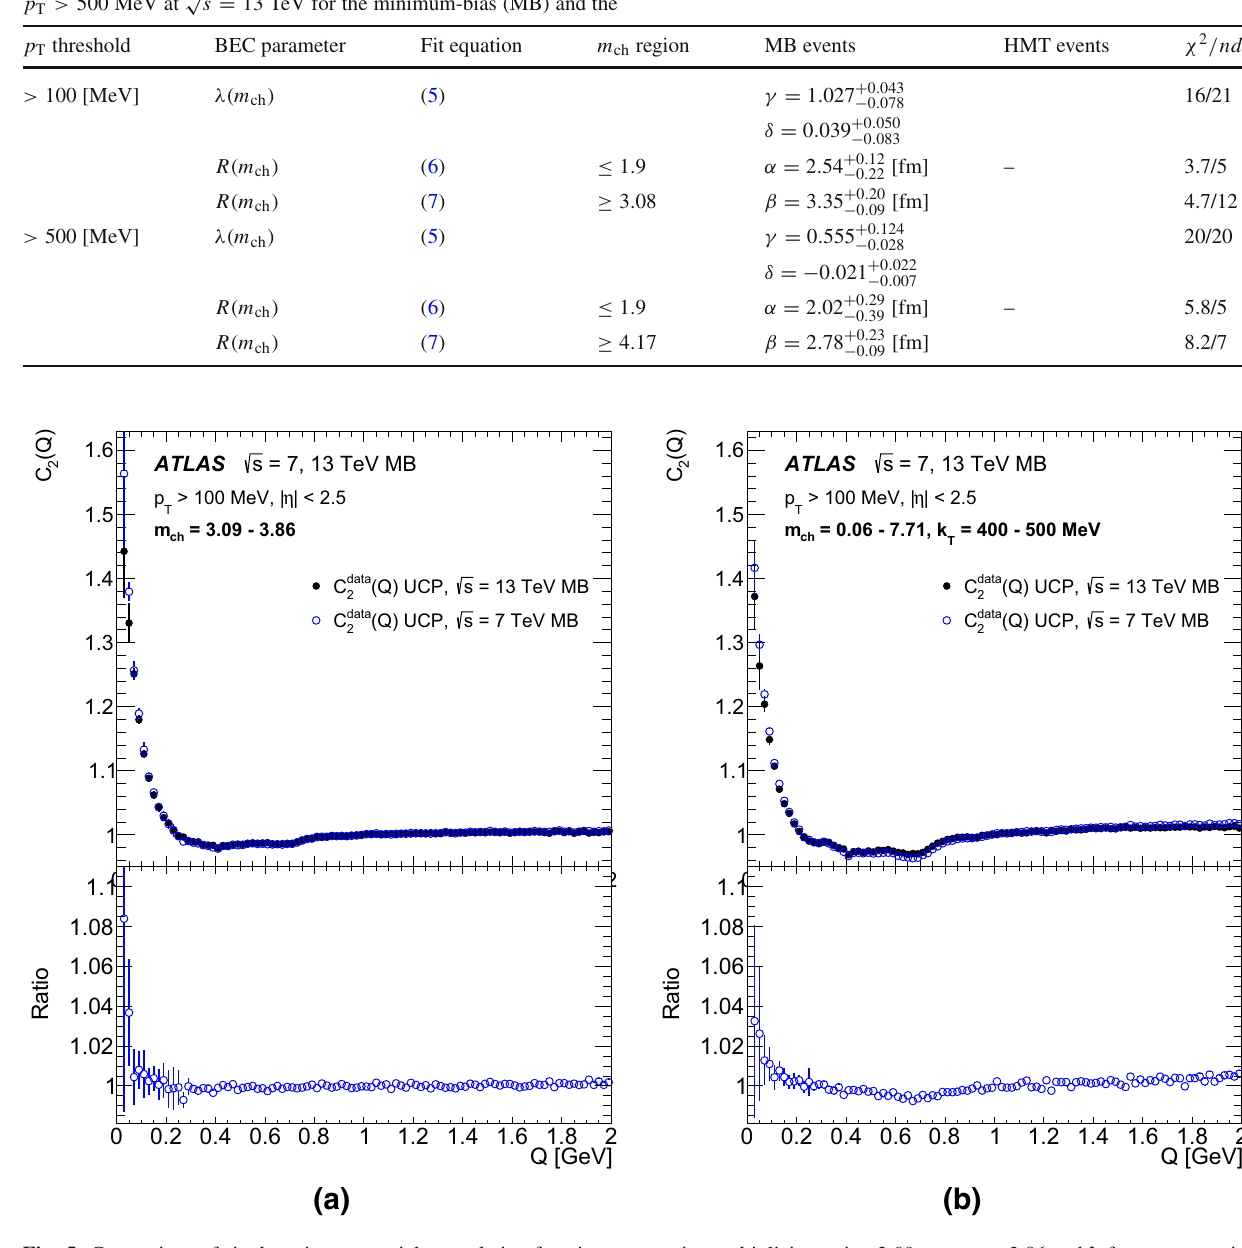
high-multiplicity track (HMT) events. The parameters γ and δ result- ing from a joint fit to the MB and HMT data are presented. The total uncertainties are shown